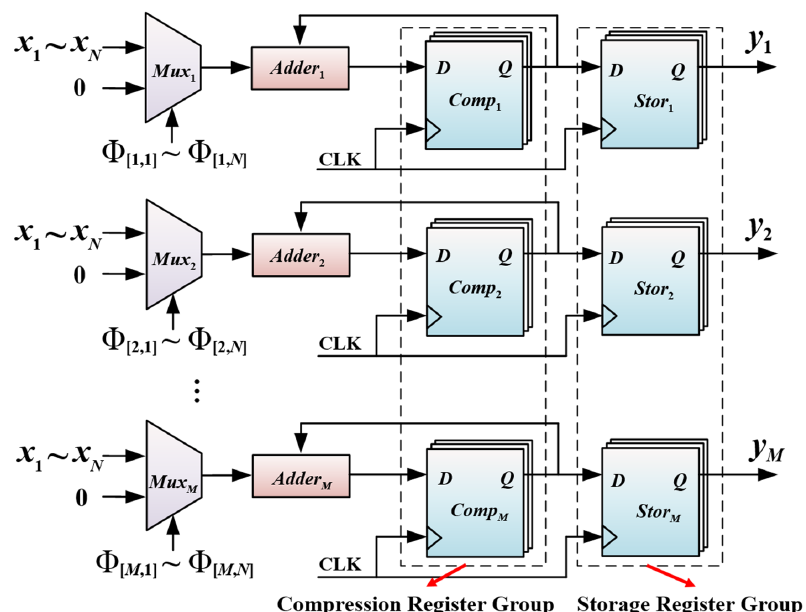
Figure 2. The compression and storage structure.